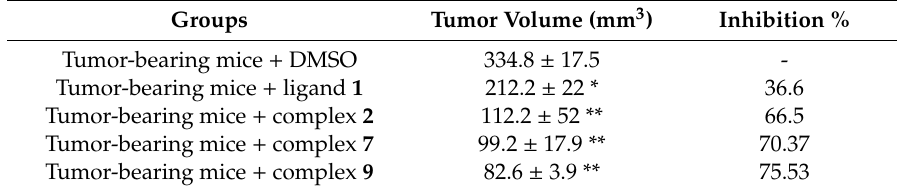
Table 6. E ff ect of ligand 1 and its metal complexes 2 , 7 and 9 on the volume of solid tumor.